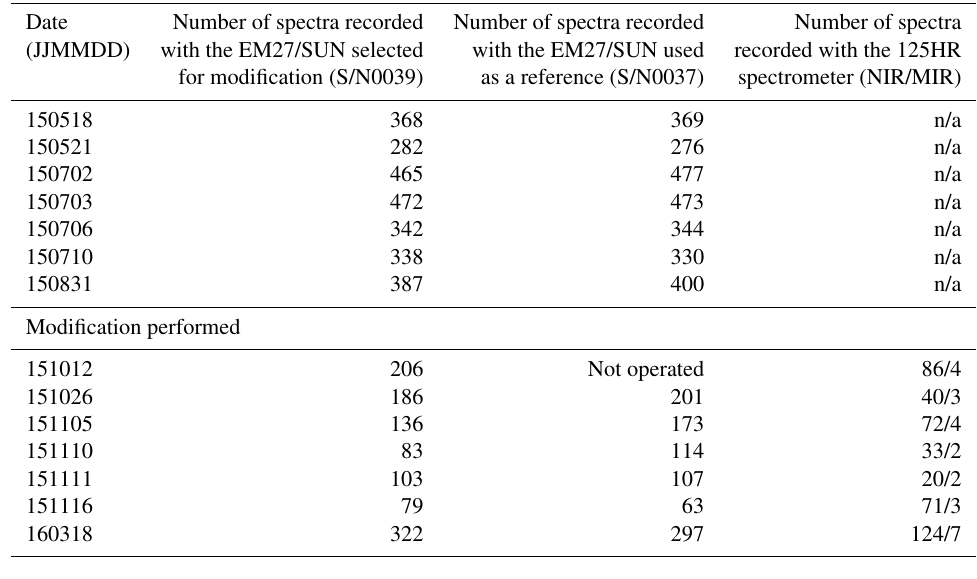
Table 1. Overview of measurement days before and after modification of the spectrometer. The number of spectra used in the comparison is indicated. The modification of the prototype was performed before 12 October 2015. NIR denotes spectra recorded in the near infrared for the TCCON analysis, MIR denotes mid-infrared observations of the fundamental band of CO as used for the NDACC analysis.